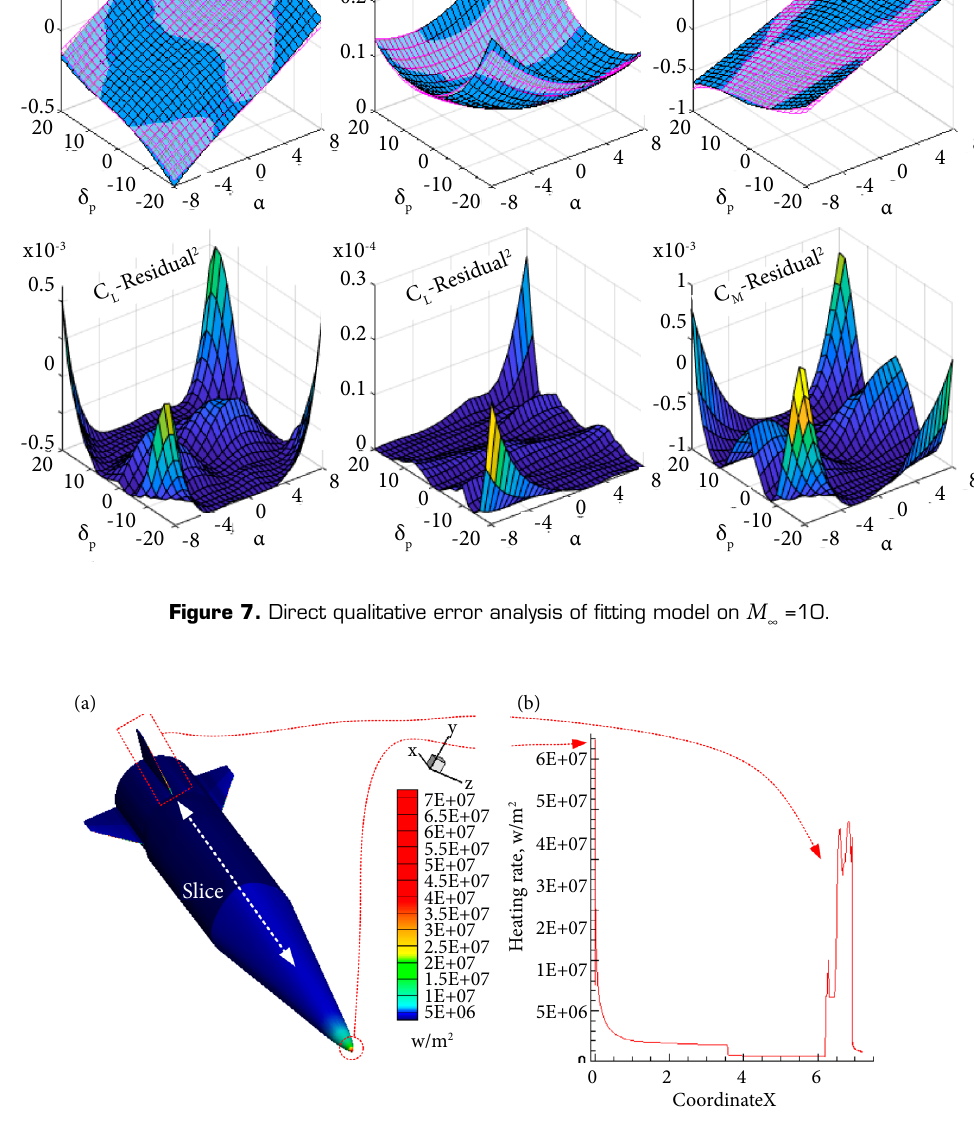
Figure 8. Aerothermodynamic environment ( M environment over PRAHV surface; (b) heating rate on a slice along center